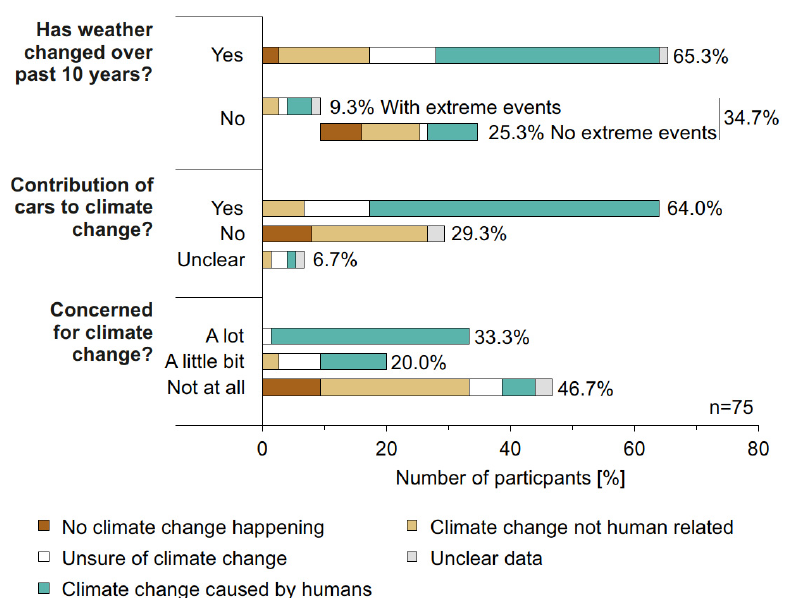
Figure 2. Participants driving for TNCs’ (Transportation Network Company) opinions on weather changes over the past decade ( top panel ), their beliefs on how cars contribute to climate change ( middle panel ), and their concern for climate change ( bottom panel ). Participants who stated that the weather had not changed over the past decade were further divided into participants that reported or did not report observing changes of extreme weather events. All responses were categorized by participants’ climate change belief categories according to Figure